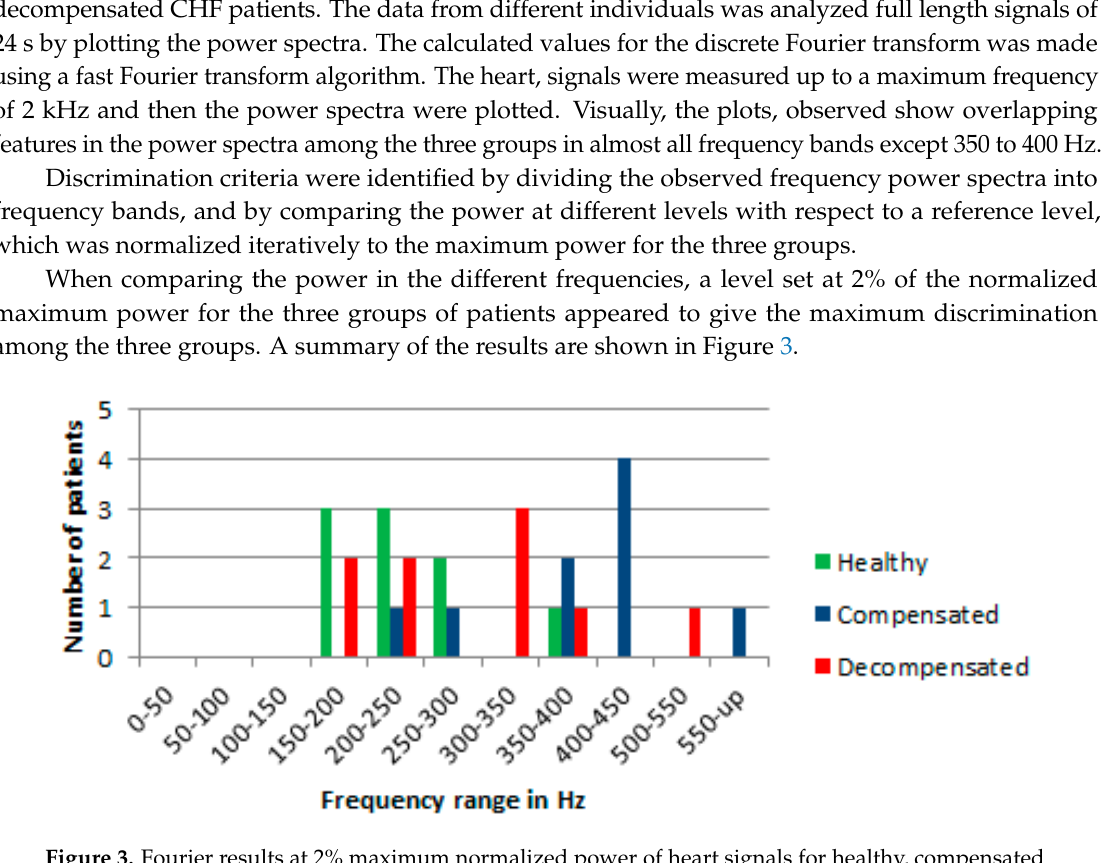
Figure 3. Fourier results at 2% maximum normalized power of heart signals for healthy, compensated and decompensated patients.